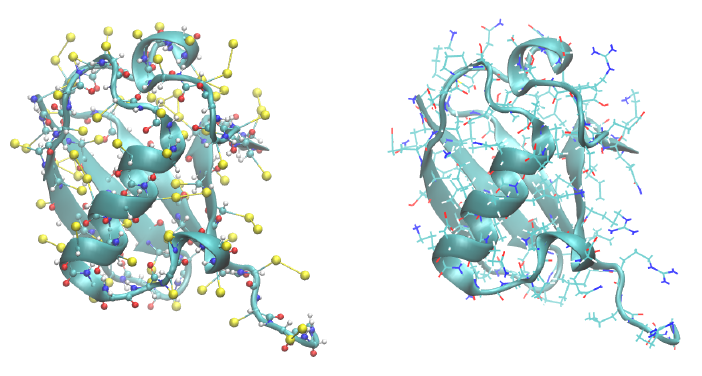
Figure 1. Structure of ubiquitin with the PACSAB model ( left ) compared to the atomistic structure ( right ). A cartoon representation has been used in both cases, plus a bead representation (with the side-chain beads in yellow) in the PACSAB